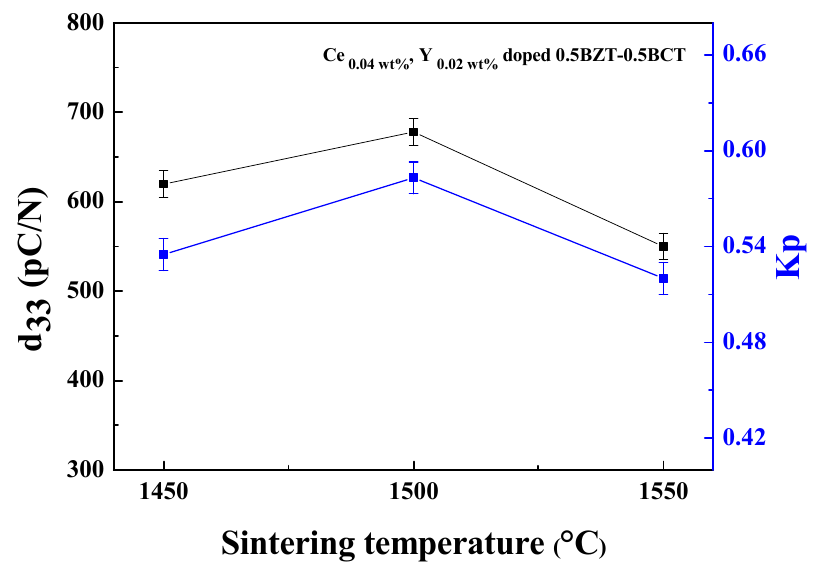
Figure 2. Sintering temperature dependent piezoelectric charge coefficient of d 33 and electro-mechanical coupling coefficient of k p of Ce 0.04 Y 0.02 -(Ba 0.85 Ca 0.15 )(Zr 0.1 Ti 0.9 )O 3 ceramics. Figure 3a,b show the X-ray diffraction patterns of Ce 0.04 Y y doped BCZT ceramic, and Ce x Y 0.02 doped BCZT ceramics, respectively. Both ceramic specimens were sintered at 1500 °C with different CeO 2 -Y 2 O 3 contents. As shown in Figure 3, all synthesized CeY doped BCZT